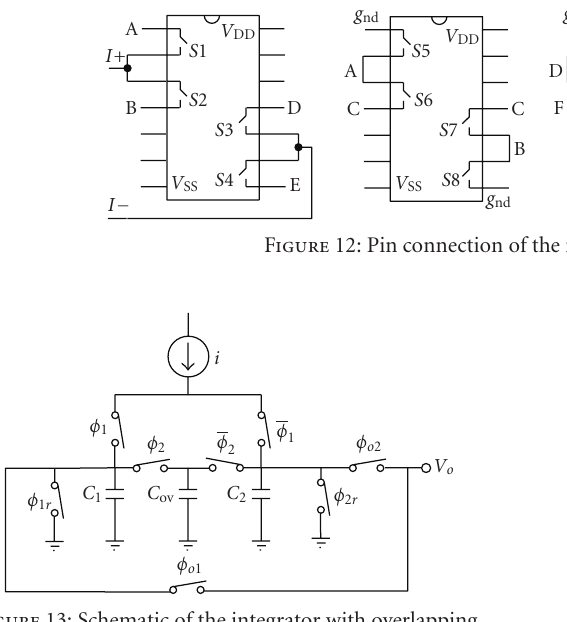
Figure 13: Schematic of the integrator with overlapping. and all the switches are implemented with transmission gate